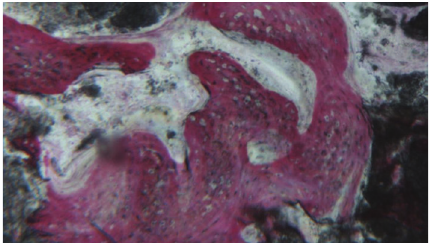
Figure 12: Histological evaluation revealed compact mature bone undergoing remodeling, marrow spaces, and newly formed tra- becular bone surrounded by several residual biomaterial particles. The newly formed bone appeared well organized. Close to the porousBCPparticles,newboneformationwasobserved,withnewly formed osteoid matrix undergoing mineralization.